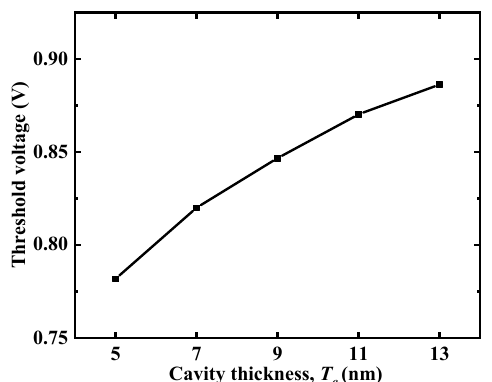
Figure 5. Threshold voltage of the DM-LTFET at V g = 1 V, V d = 0.5 V, and k = 23.